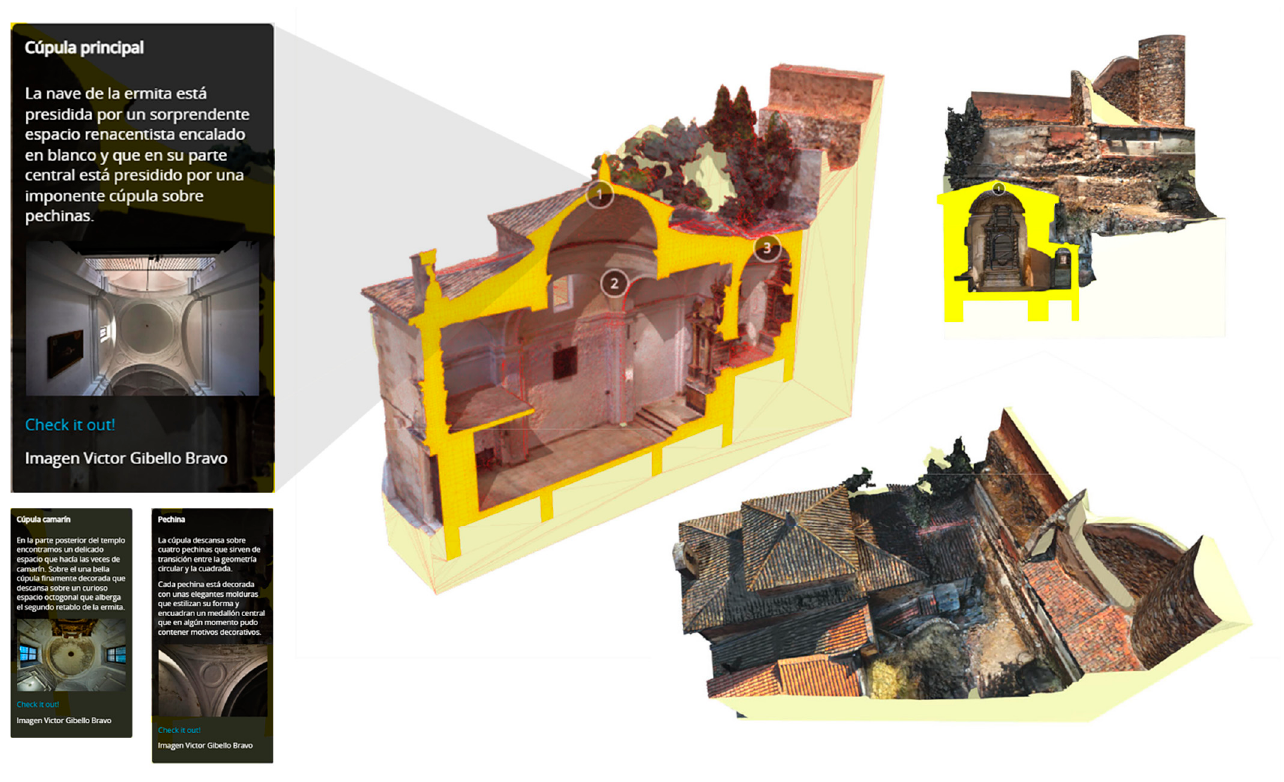
Figure 11. Assembly of the proposed model.